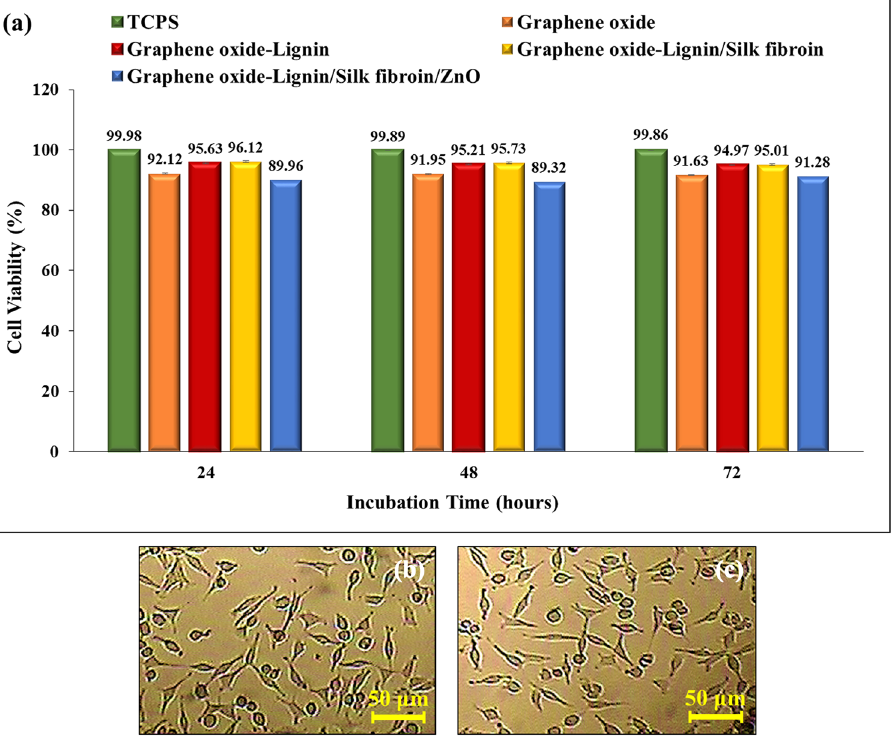
Figure 6. ( a ) Histogram of the cell viability percentage after different incubation times of TCPS, graphene oxide, Graphene oxide-Lignin, Graphene oxide-Lignin/silk fibroin and nanobiocomposite. ( b ) Untreated Hu02 cell line morphology and ( c ) Hu02 cell line morphology after treatment with Graphene oxide-lignin/silk fibroin/ ZnO nanobiocomposite after 72 h incubation.